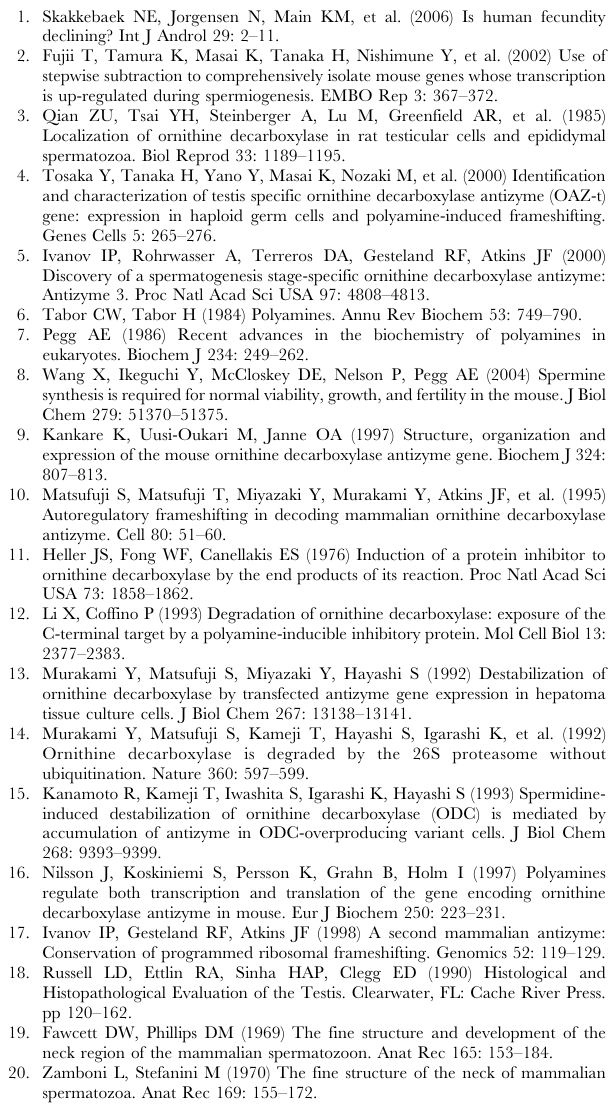
Table S2 Polyamine contents in testis and epididymis. Found at: doi:10.1371/journal.pgen.1000712.s003 (0.04 MB DOC) Video S1 Motility of the OAZ-t + / 2 sperm in TYH medium. Sperm were collected from the cauda epididymides, placed in chamber slides, and observed in real time by light microscopy after 5 h. The OAZ-t + / 2 sperm exhibited normal motility.